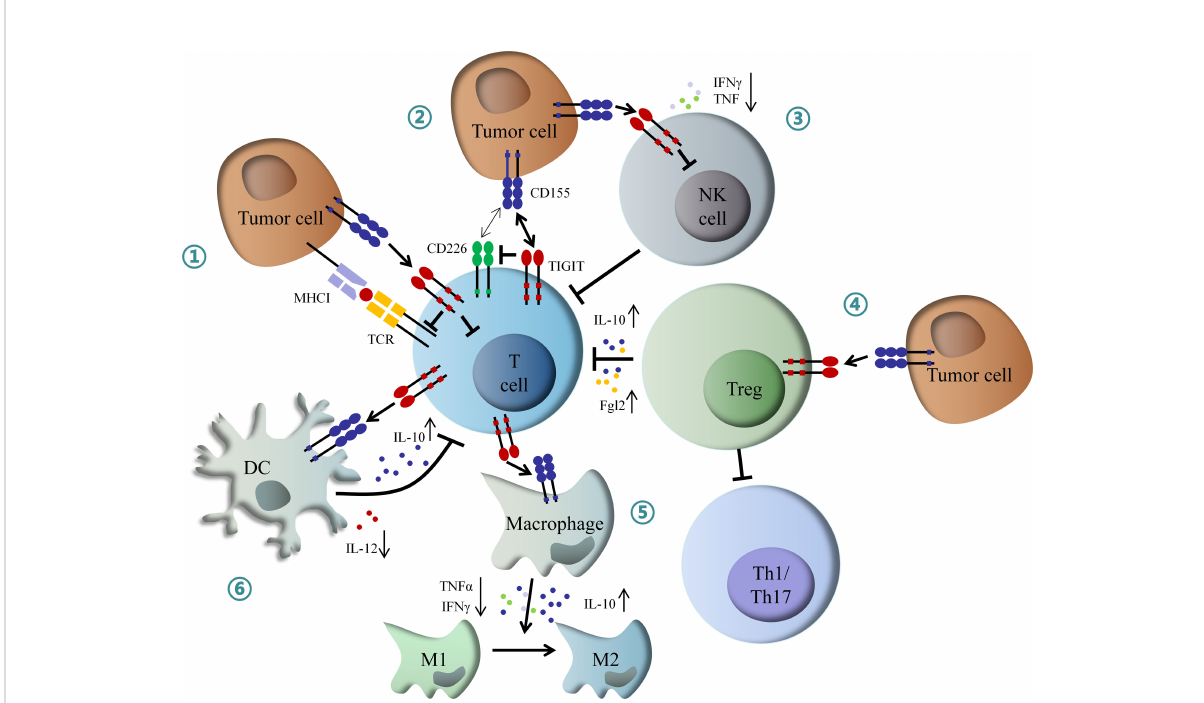
FIGURE 2 Mechanism of inhibitory role of TIGIT in immunoregulation. (1) Interaction of TIGIT with CD155 transmits intracellular inhibitory signals, which directly suppressed TCR signal and effector T cell function. (2) TIGIT inhibits CD226-induced T cell activation by disrupting CD226 homodimerization and decreasing IFN g production. (3) TIGIT directly induces NK cell exhaustion, contributing to inactivation of CD8+ T cell. (4) TIGIT enhances Tregs mediated dysfunction of effector T cell by increased IL-10 and Fgl2, as well as inhibition of Th1 and Th17 cells. (5) TIGIT promotes macrophage switching from pro-in fl ammatory M1 to anti-in fl ammatory M2 phenotype through increased IL-10 and decreased IFN g and TNF a . (6) TIGIT inhibits T cell function by DCs-mediated abnormal secretion of cytokines. IFN g , interferon- g ; IL-10, interleukin-10; Fgl2, fi brinogen-like protein 2; Th1, T helper 1 cell; Th17, T helper 17 cell; TNF a , tumor necrosis factor a ; DCs, dendritic cells; NK, natural